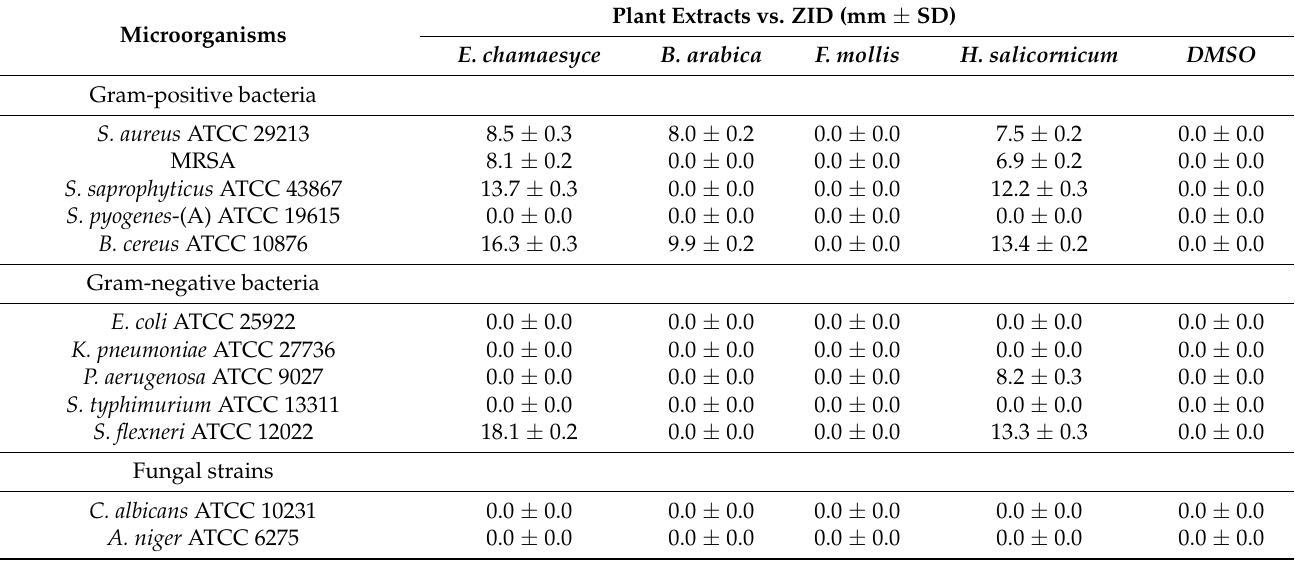
Table 2. Preliminary antimicrobial activity of F. mollis , B. arabica , H. salicornicum , and E. chamaesyce plant extracts.